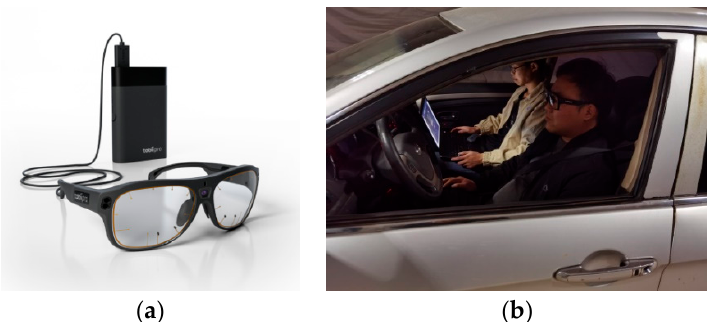
Figure 6. Acquisition of a driver’s pupil diameter data. ( a ) Eye tracker, ( b ) the driver wearing eye tracker.